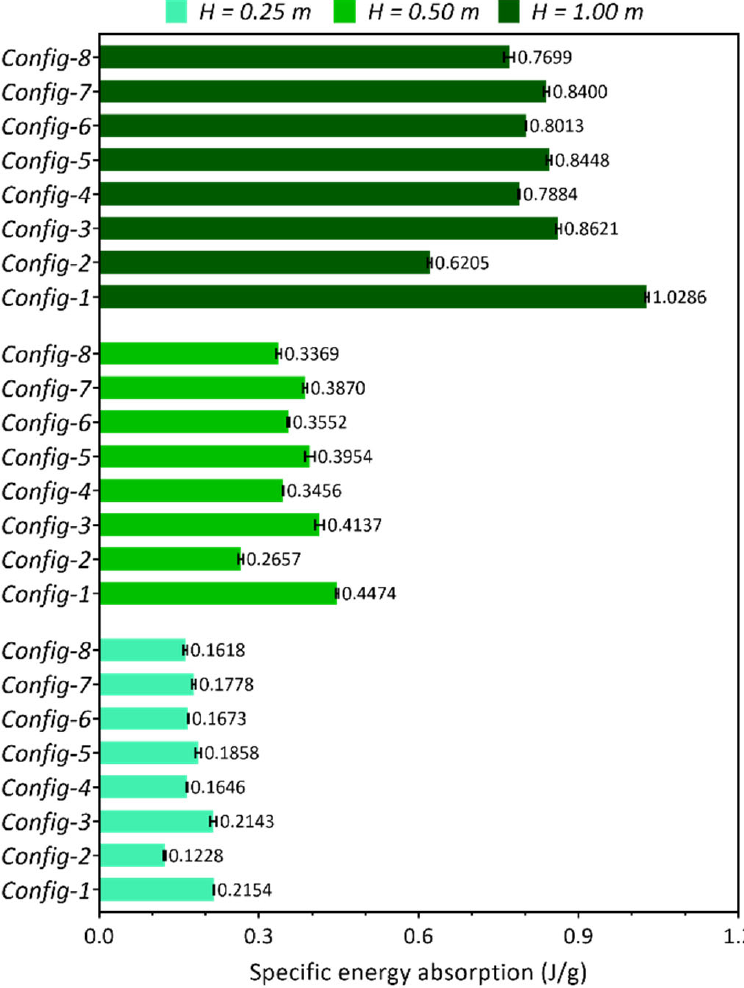
Figure 8. Specific energy absorbing capacities for configurations.